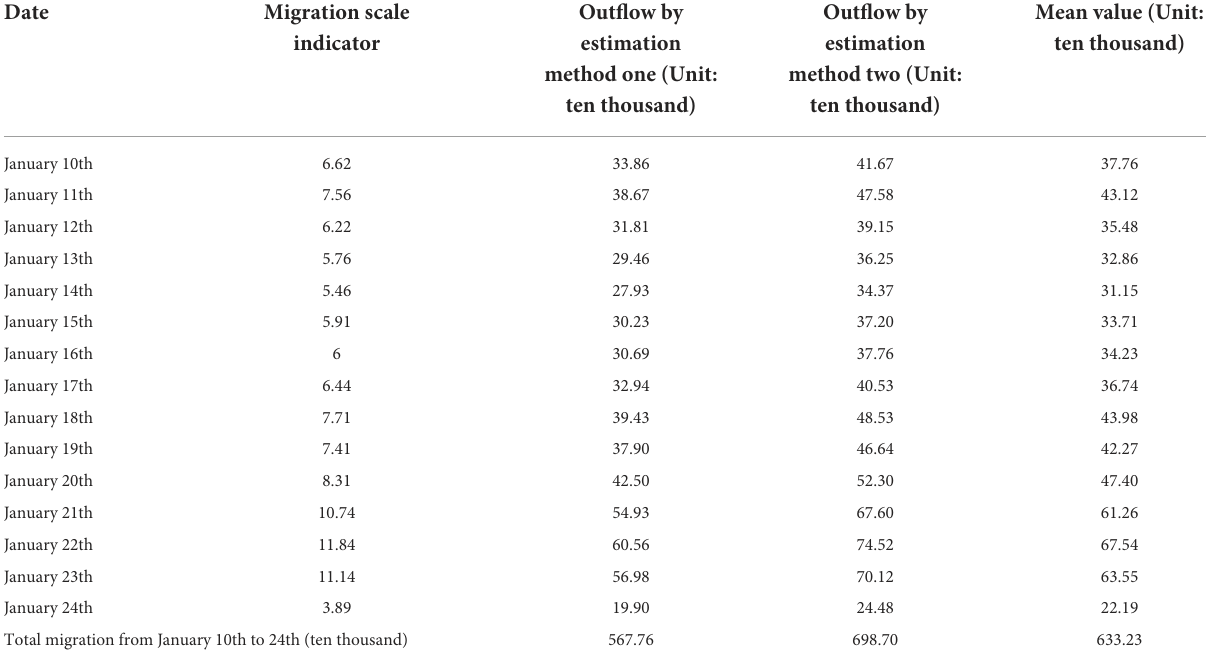
TABLE 1 Population outflow from Wuhan before the Spring